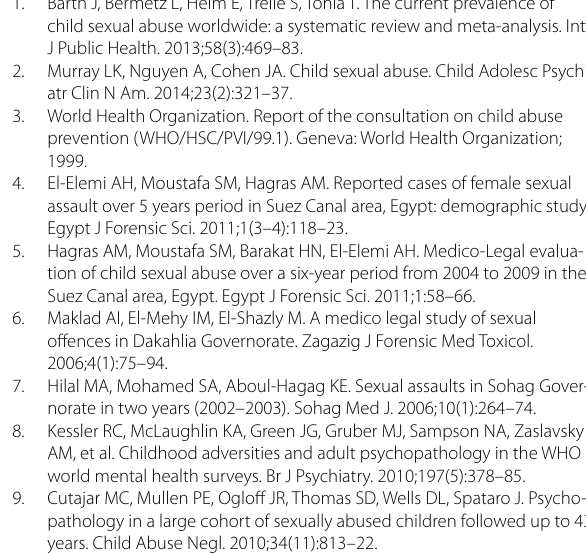
BDI-II Beck Depression Inventory, second edition, BHS Beck Hopelessness Scale